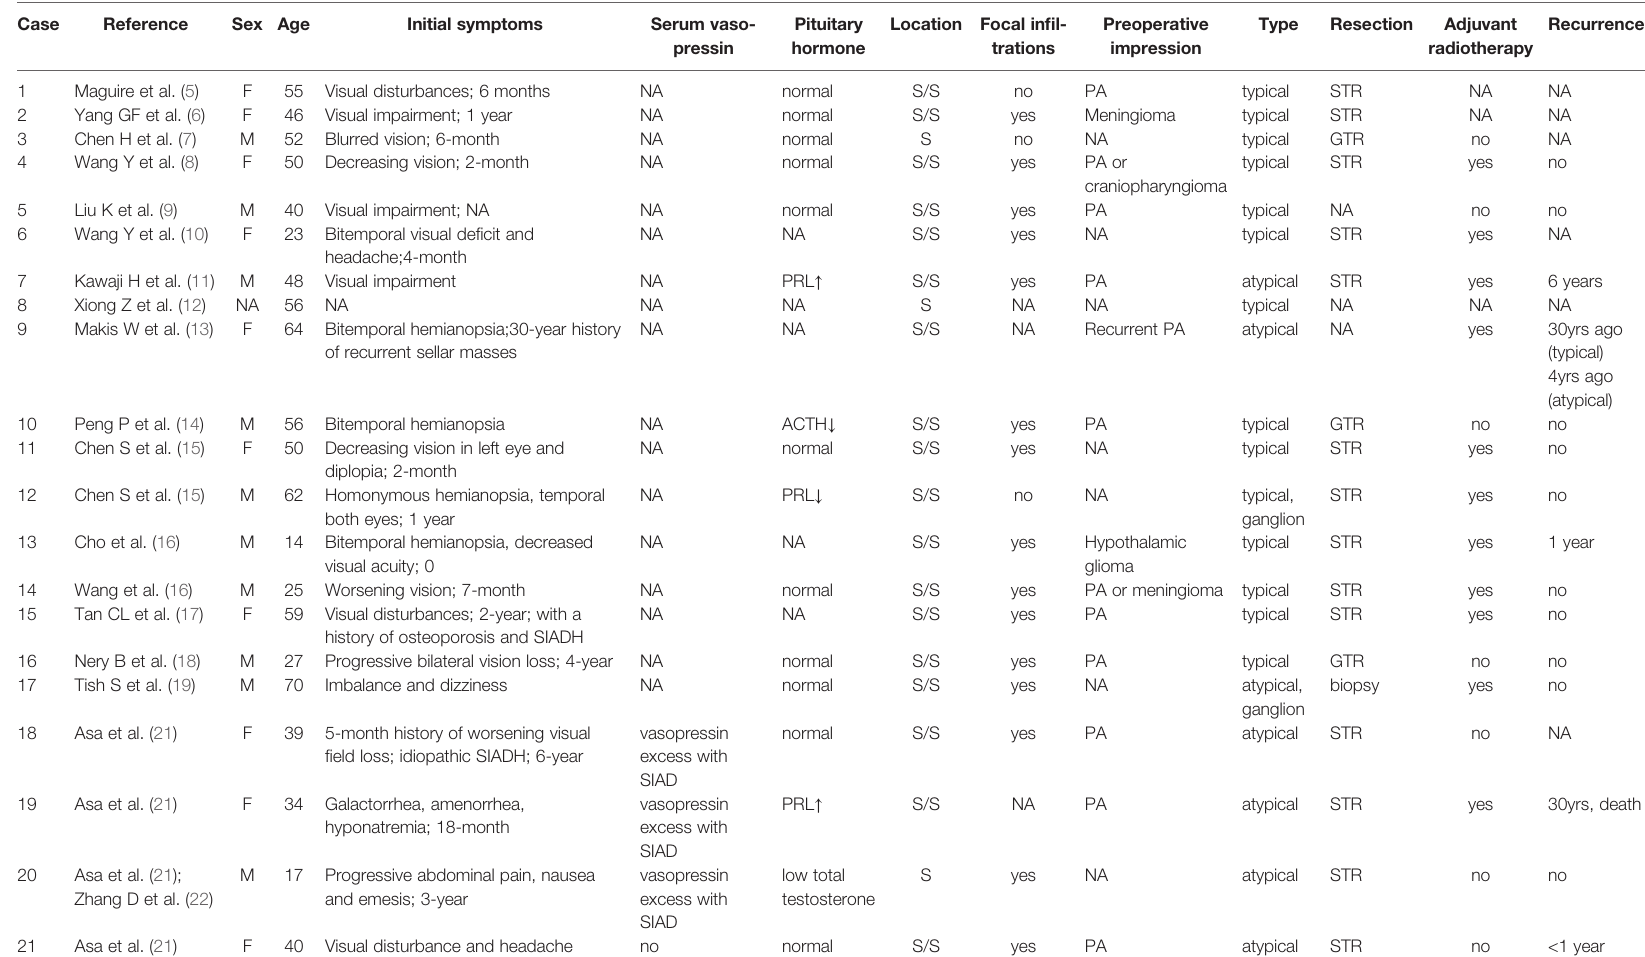
TABLE 3 | Clinicopathological details of the 21 reported cases of sellar/suprasellar